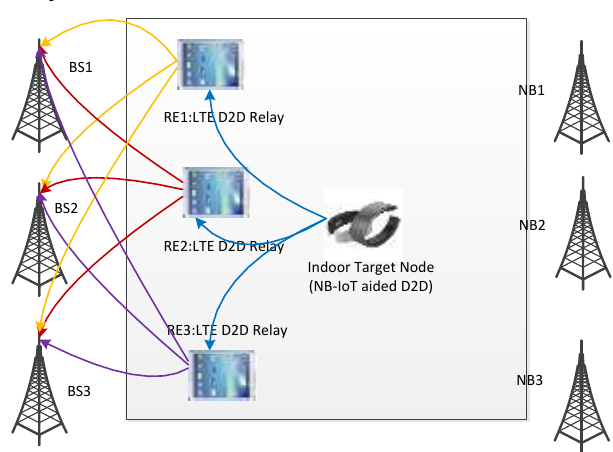
Figure.1 In the coverage area of NB-IoT and D2D relays